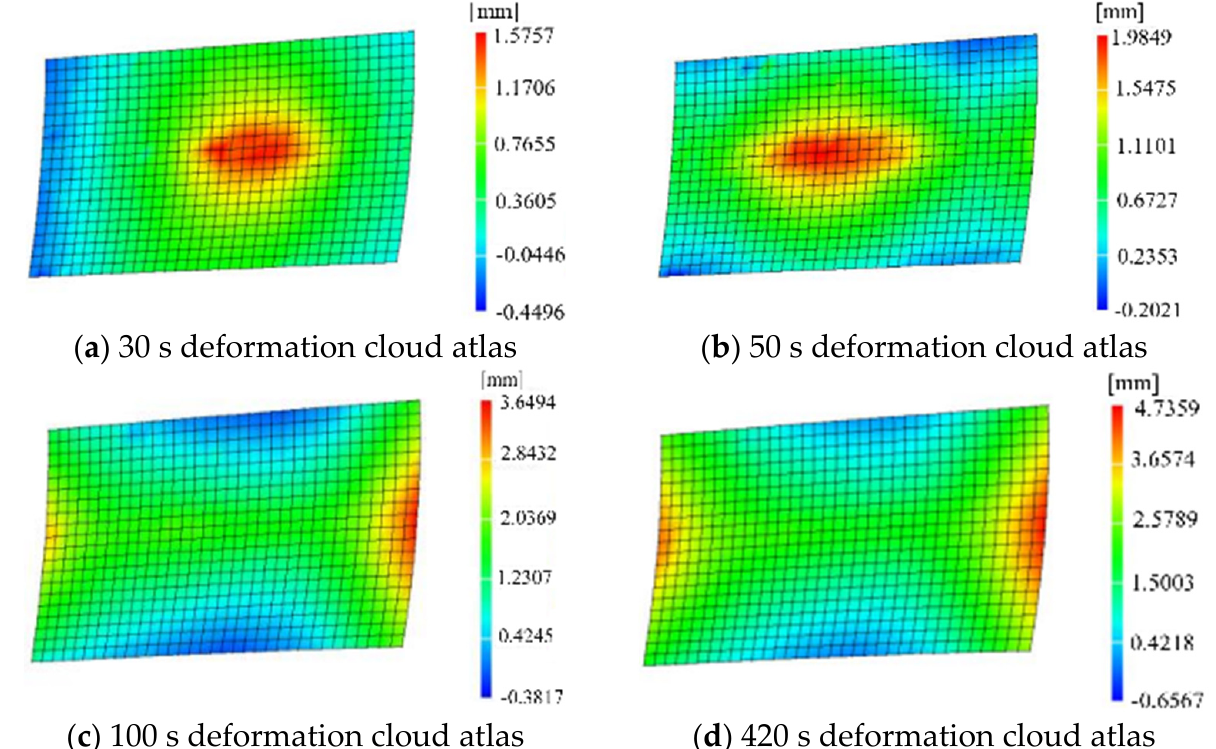
Figure 5. Out-of-plane deformation cloud atlas of the thin bending plate. ( a ) 30 s; ( b ) 60 s; ( c ) 100 s; ( d ) 420 s.